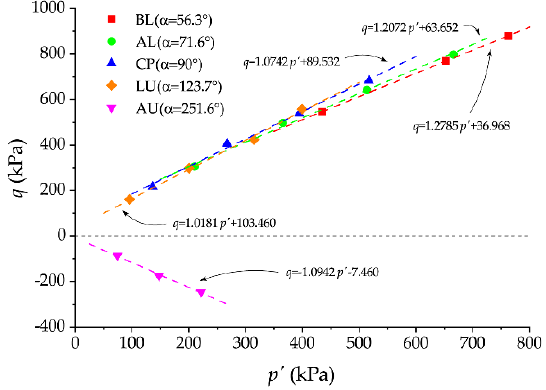
Figure 11. Failure lines of the soil under different stress paths.